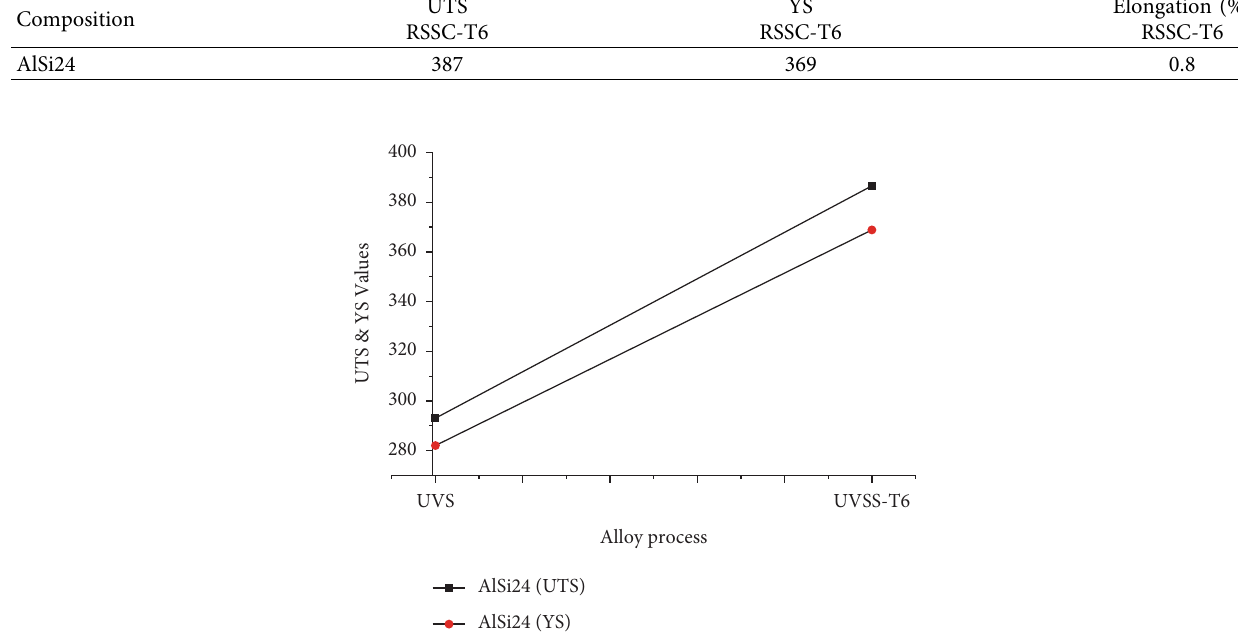
Figure 8: UTS and YS values of AlSi24